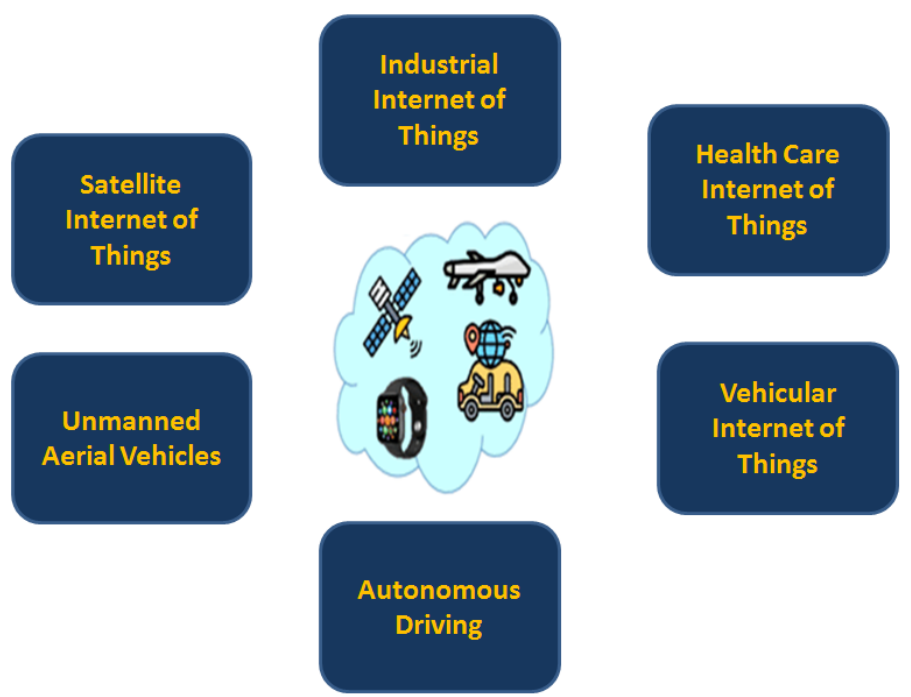
Figure 13. UAV systems light weight authentication domains.